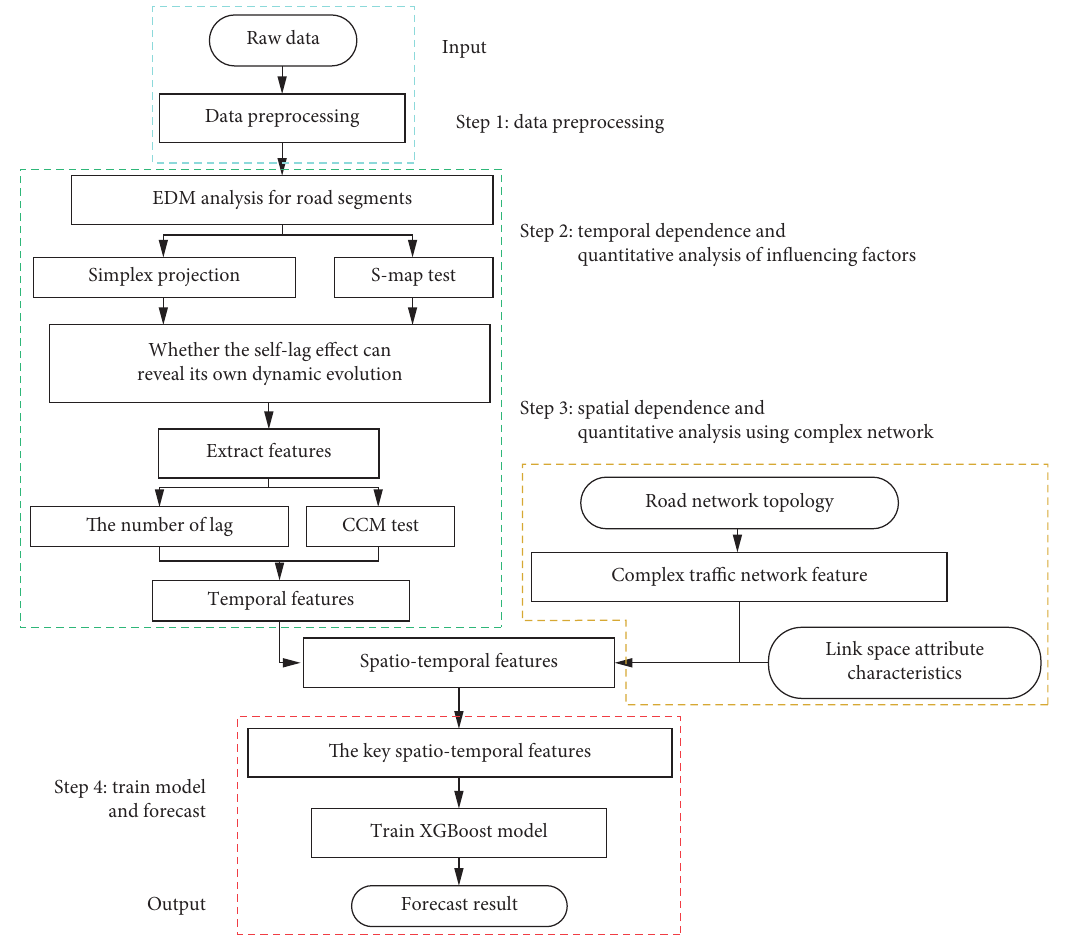
Figure 1: Framework of the proposed